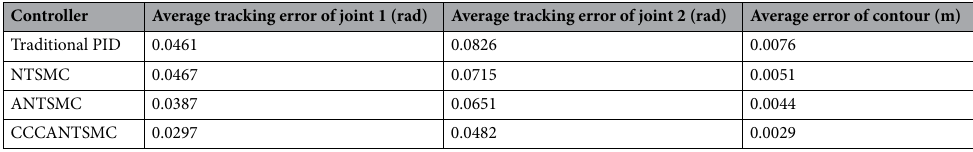
Table 2. Performance comparison of each